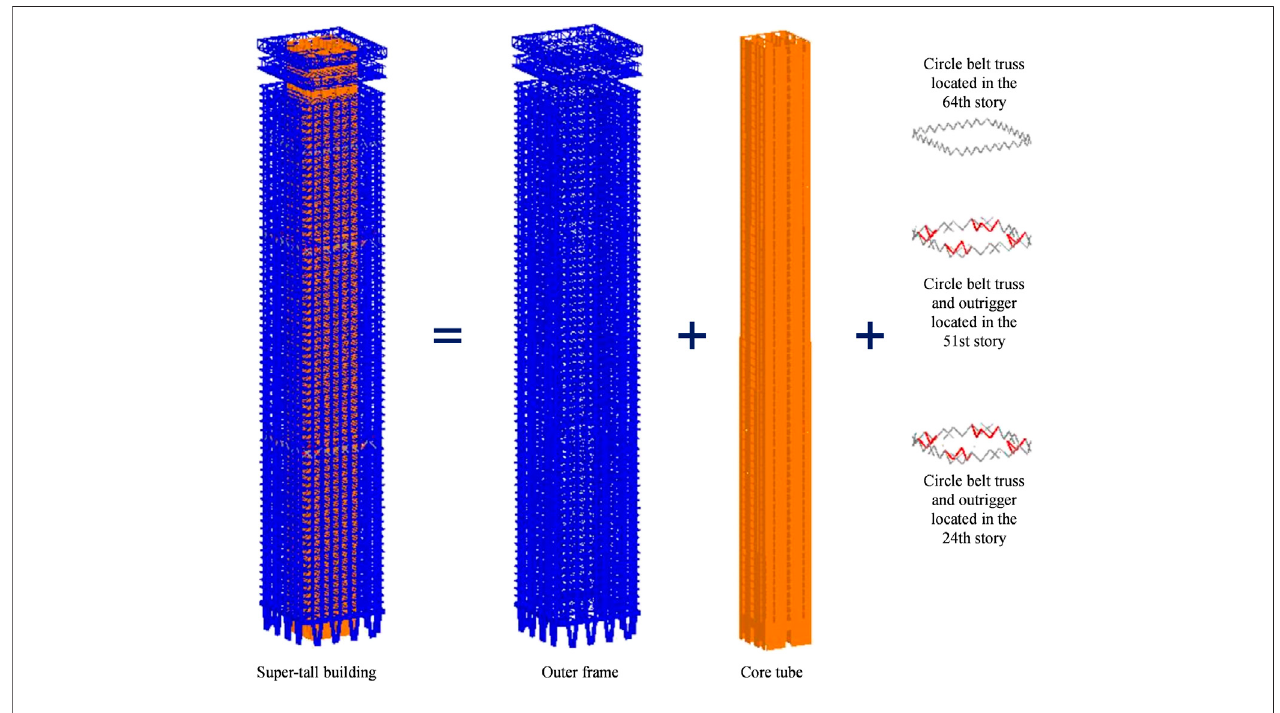
FIGURE 1 | Structural lateral-load-resisting system.